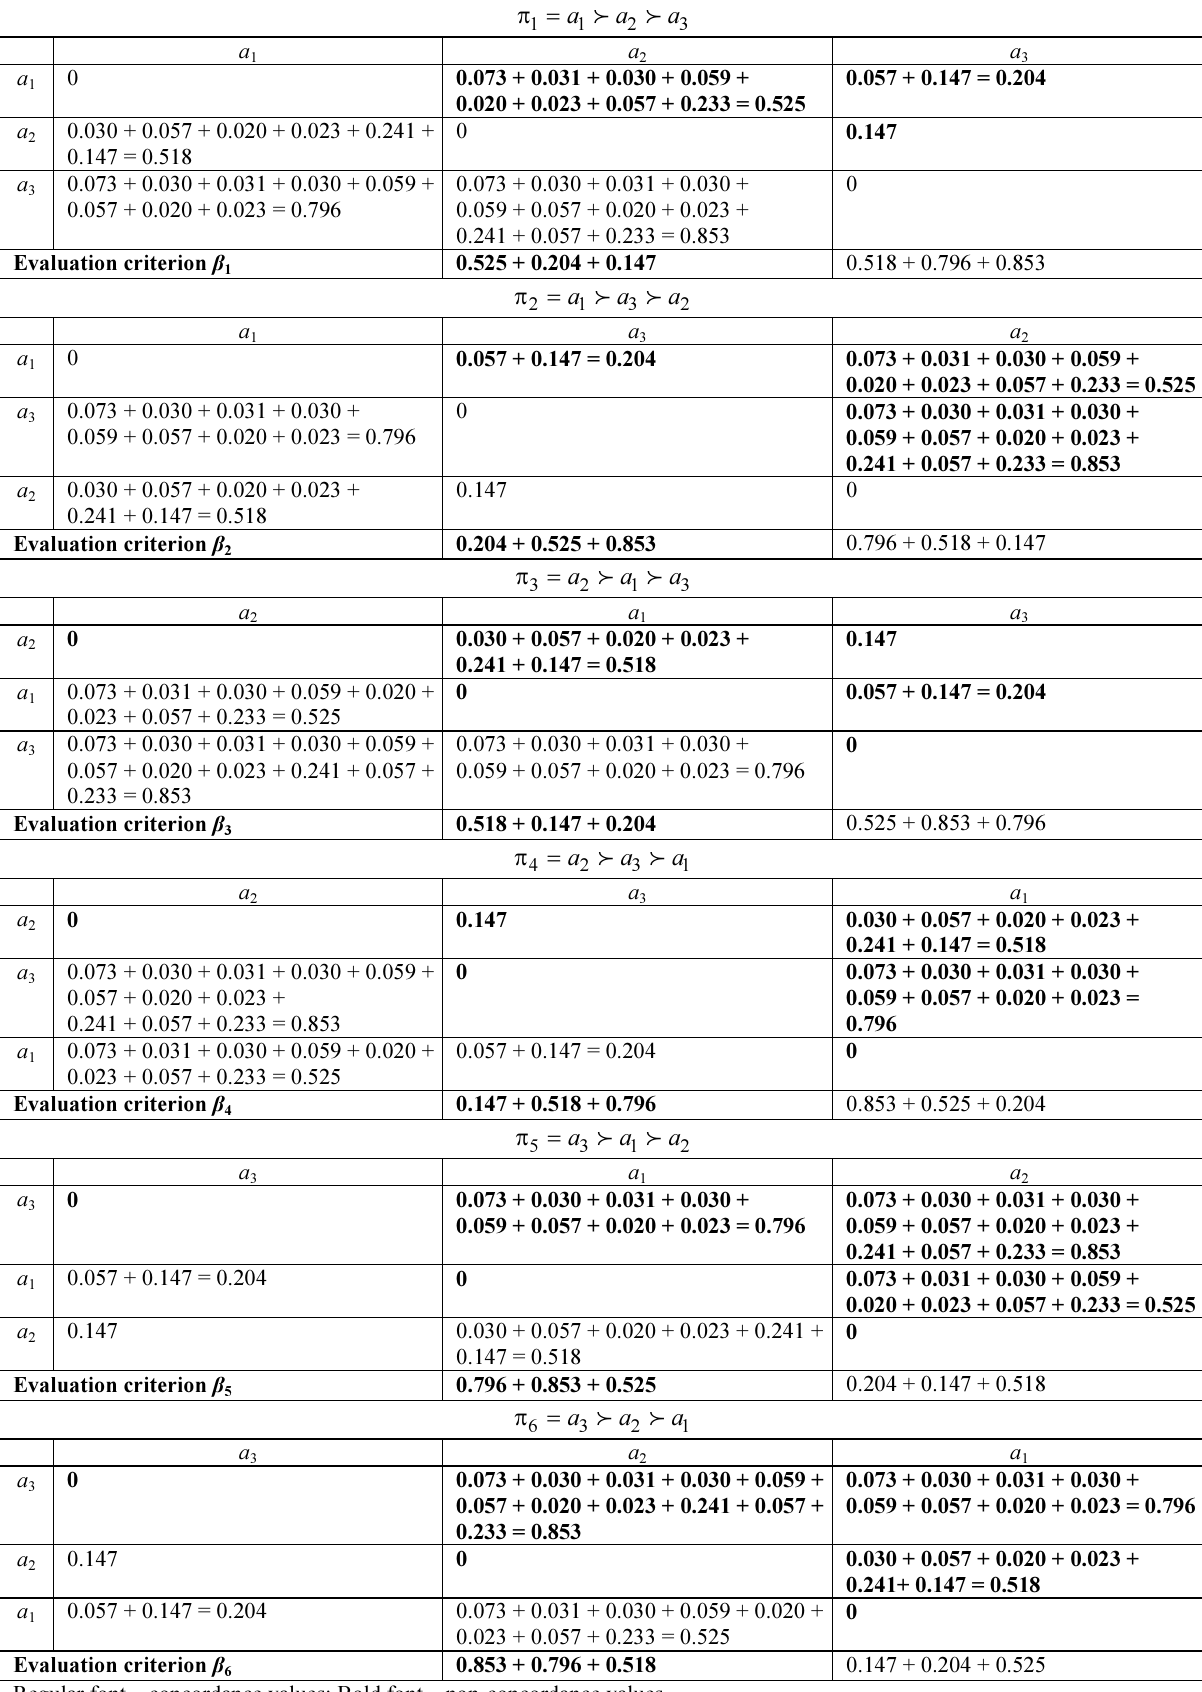
Table 5. Permutations and calculations of evaluation